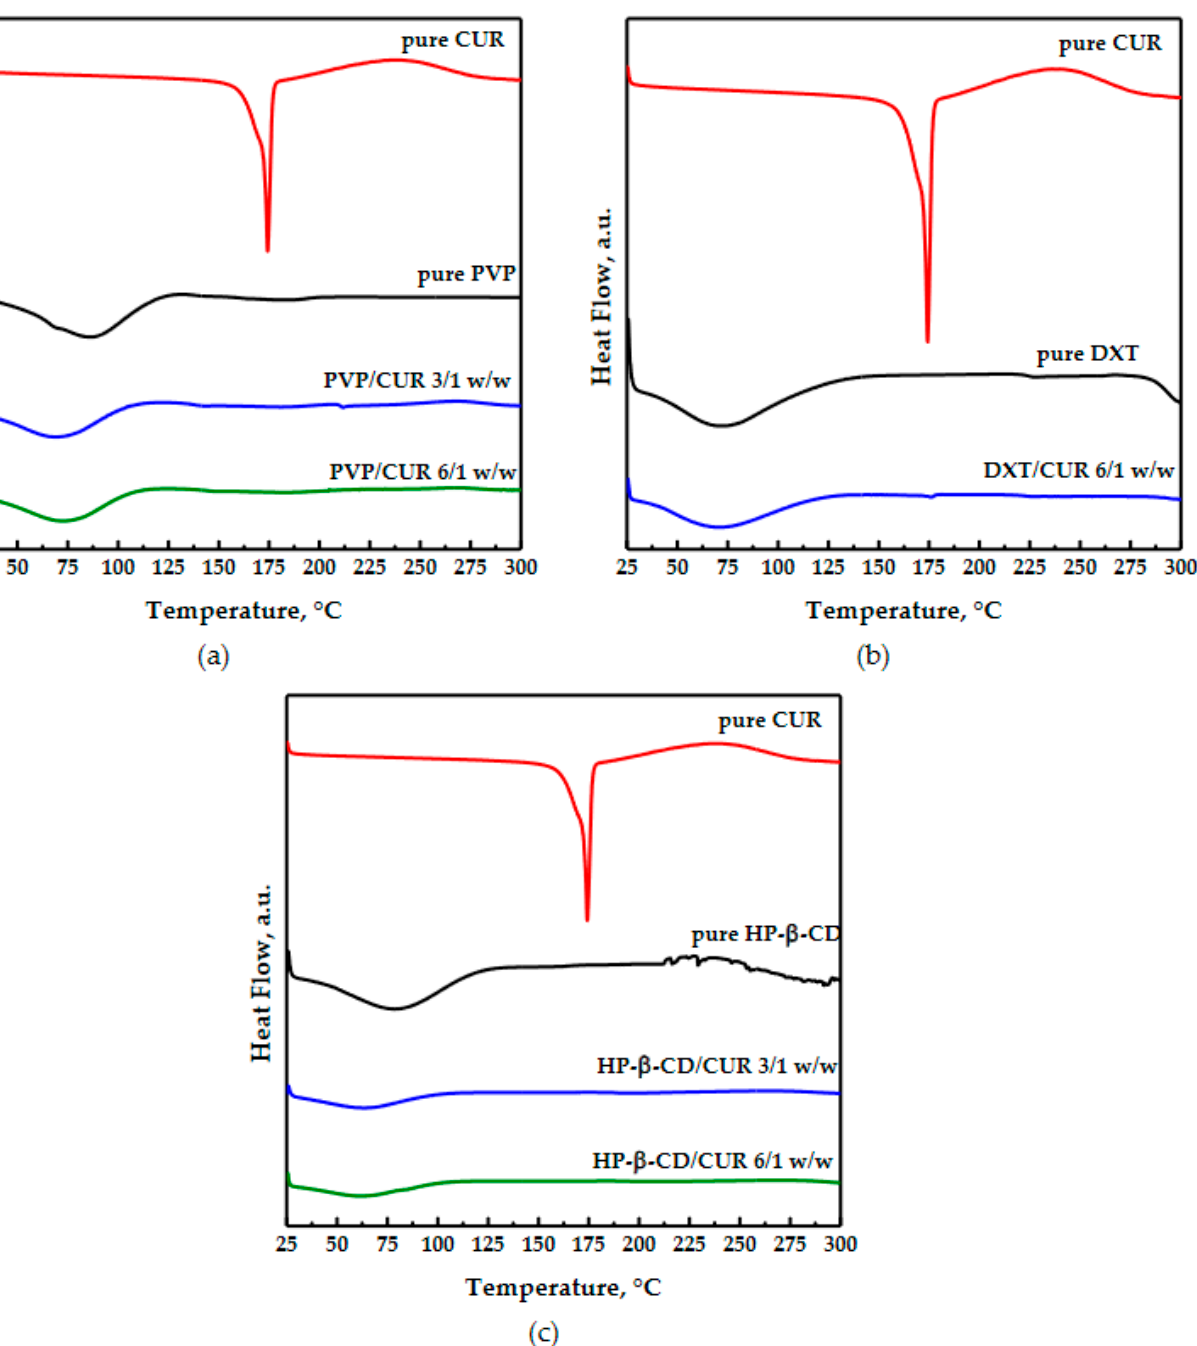
Figure 6. Diffractograms of unprocessed carriers and CUR and SAA processed carrier/CUR powders: ( a ) PVP; ( b ) DEX; ( c ) HP- β -CD.